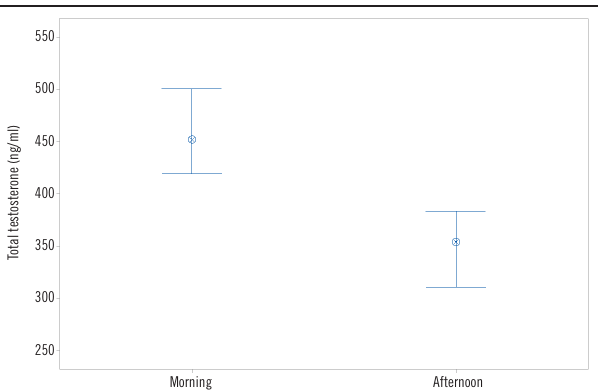
FIGURE 2 – Distribution of median values of total testosterone in the morning and afternoon periods